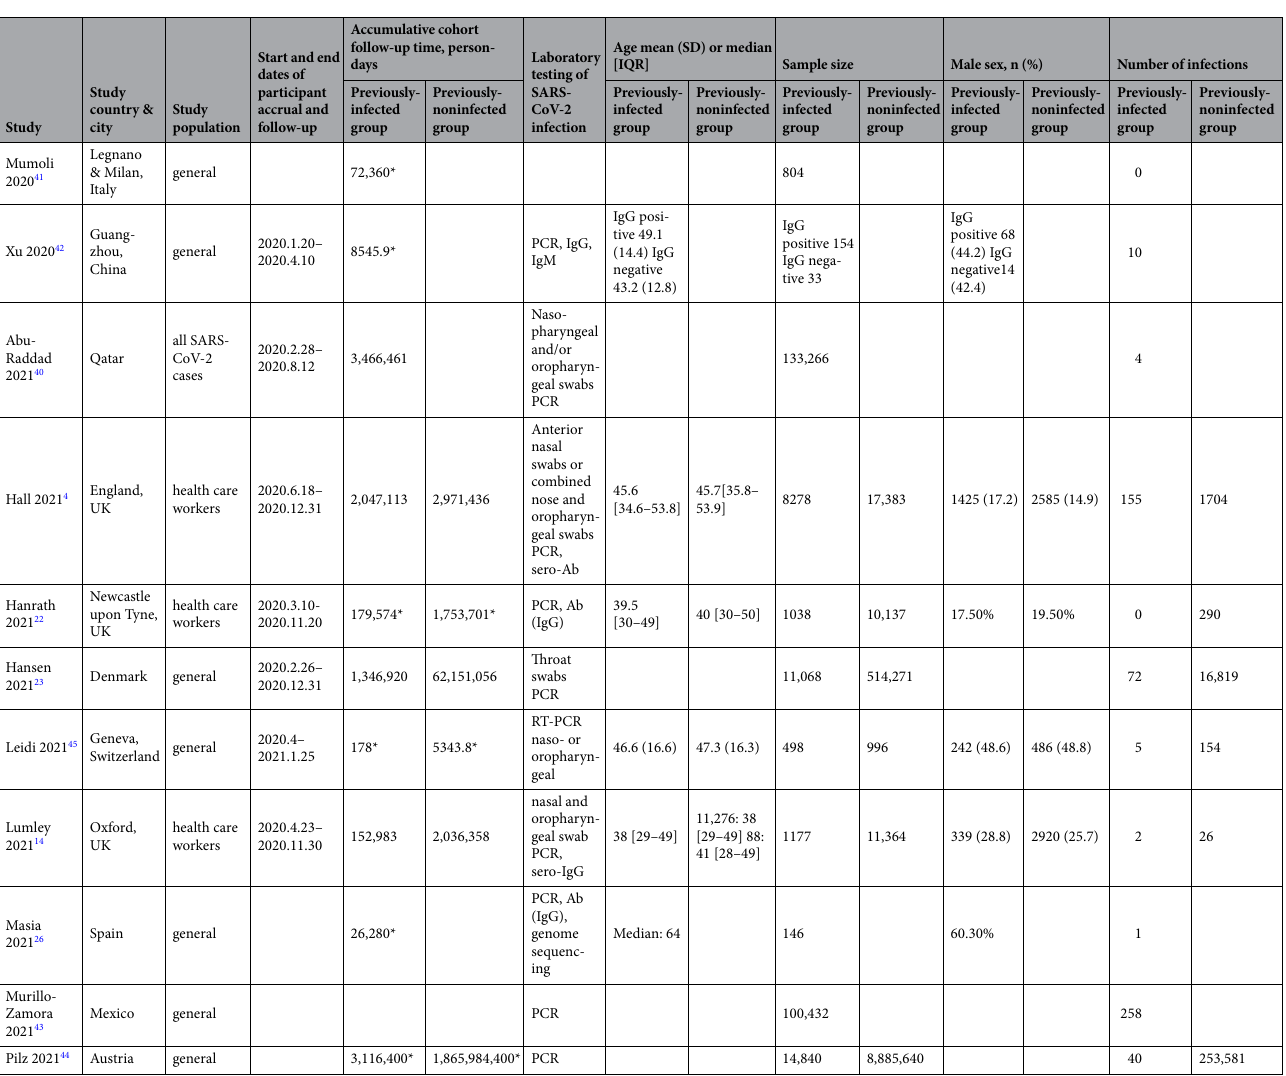
Table 1. Characteristics of included epidemiological studies. SD standard deviation; IQR interquartile range; PCR polymerase chain reaction; IgG immunoglobulin G; IgM immunoglobulin M; Ab antibody. *The duration of follow-up was calculated through multiplying sample size by median or mean follow-up